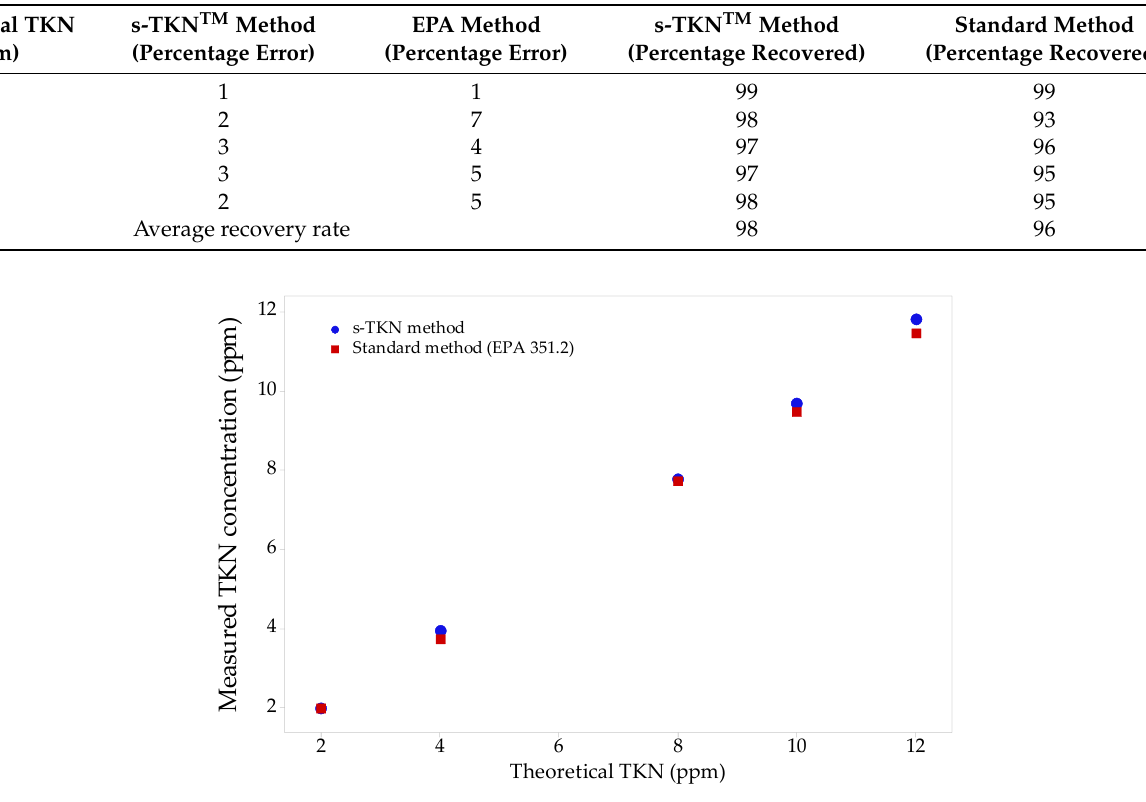
Table 1. Error rate and recovery rate of nitrogen using the simplified TKN method and the standard method (EPA 351.2) using the nicotinic acid-PTSA standard.